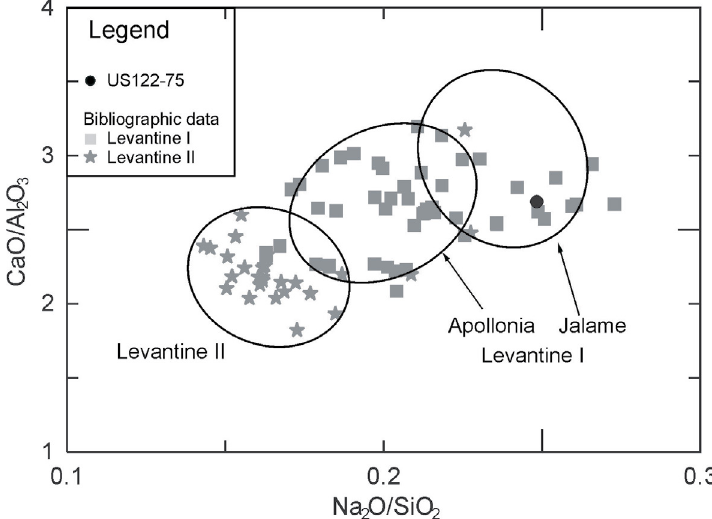
Figure 7: Ternary plots for the samples of the first group compared with the bibliographic data of natron-type glasses distribu- ted in the Mediterranean area and Europe for most of the first millennium AD. Bibliografic data from: Brems et al., 2018; Ceglia et al., 2015, 2019; De Juan Ares et al., 2019a; Foy et al., 2003; Gliozzo et al., 2019; Phelps et al., 2016; Schibille et al., 2017,